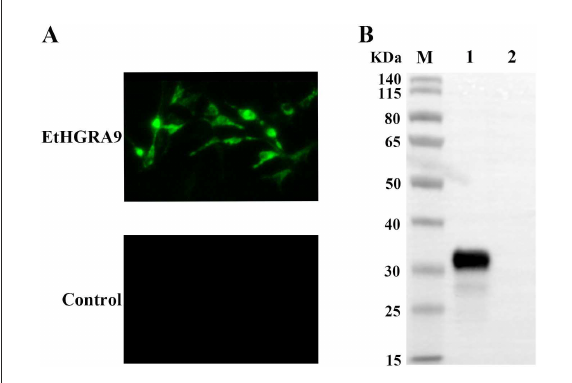
FIGURE2 Expression analysis of EtHGRA9 in the transfected LMH cells. (A) Fluorescence microscopic photographs of the transfected LMH cells labeled by HA-tag mouse monoclonal antibody. (B) Western blot analysis of the transfected LMH cells using HA-tag mouse monoclonal antibody as the primary antibody. Lane 1: protein extracts from the LMH cells transfected with the EtHGRA9 overexpression plasmid; lane 2: protein extracts from the LMH cells transfected with the empty plasmid.